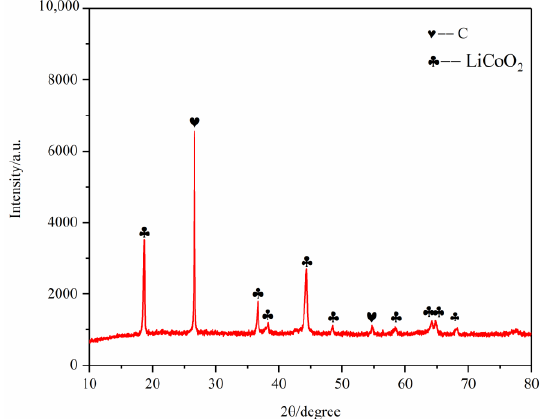
Figure 14. SEM of battery materials after pyrolysis at 400 °C.